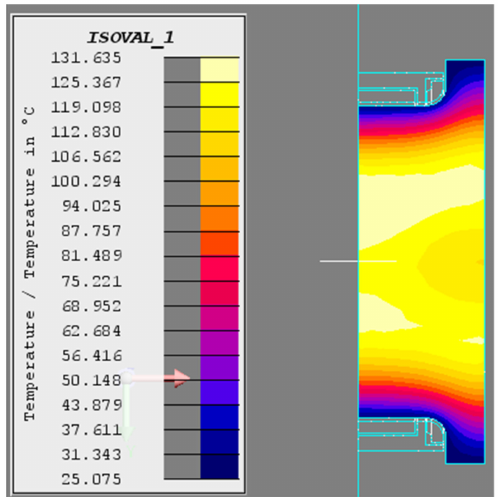
Figure 11. Temperature field of the crankshaft (T = 10 s).